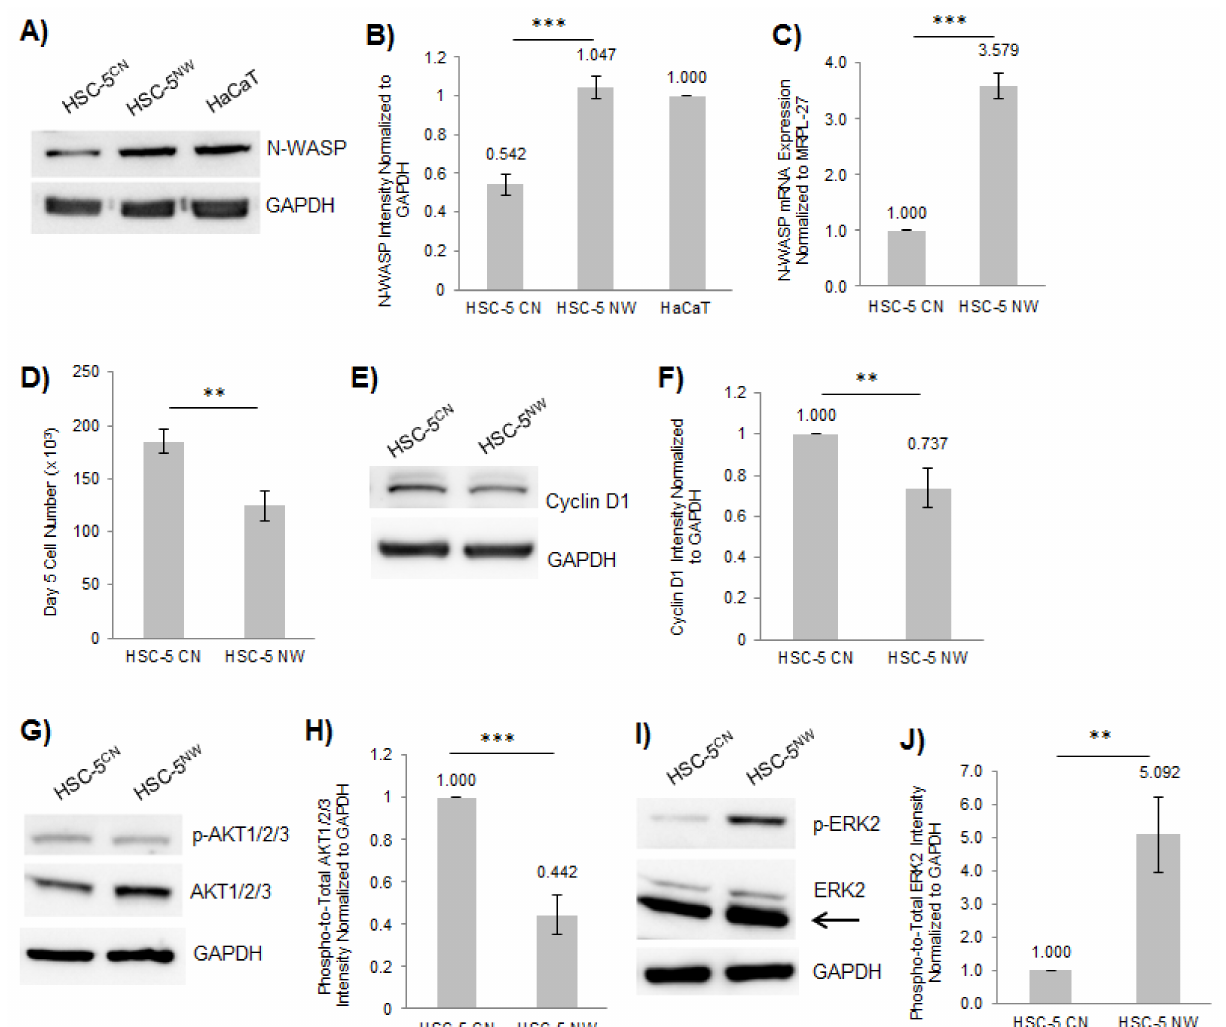
Figure 2. Exogenous expression of N-WASP in HSC-5 cells reduced cell proliferation but increased pERK2 levels. ( A ) Representative Western blots of N-WASP and GAPDH in HSC-5 CN , HSC-5 NW and HaCaT cells; n = 3. ( B ) Densitometric quantification of the N-WASP/GAPDH ratio in each cell line normalized to HaCaT cells. ( C ) The total RNA was extracted from HSC-5 CN and HSC-5 NW cells, reverse-transcribed to cDNA for quantifying N-WASP expression relative to MRPL-27 using real-time PCR and subsequently normalized to HSC-5 CN cells. ( D ) The graph shows the total cell number after 5 days of incubation of HSC-5 CN and HSC-5 NW cells. ( E , G , I ) Representative Western blots of ( E ) Cyclin D1, ( G ) pan-AKT1/2/3 and pAKT1/2/3, and ( I ) pan-ERK1/2 and pERK1/2, and GAPDH in HSC-5 CN and HSC-5 NW cells; n = 3. ( F , H , J ) Densitometric quantifications of the ratio of ( F ) cyclin D1/GAPDH, ( H ) pAKT1/2/3/pan-AKT1/2/3, and ( J ) pERK2/pan-ERK2 in HSC-5 CN and HSC-5 NW cells normalized to HSC-5 CN cells. All values are the mean ± SD, n = 3, ** p < 0.01, *** p < 0.001. N-WASP plays a critical role in cell-cell adhesion through a non-canonical post- nucleation pathway [42]. We visualized the localization of E-cadherin, a cell-cell adhe- sion molecule, via immunofluorescence staining of the HSC-5 sublines. HSC-5 NW cells had increased localization of E-cadherin at cell-cell junctions compared to HSC-5 CN cells E-cadherin protein expression, as determined by Western blot analysis (Figure 3C,D). This suggests that the increased localization in E-cadherin is not due to increased protein ex- pression; rather, it is due to enhanced E-cadherin localization to the cell-cell junctions as a result of increased N-WASP